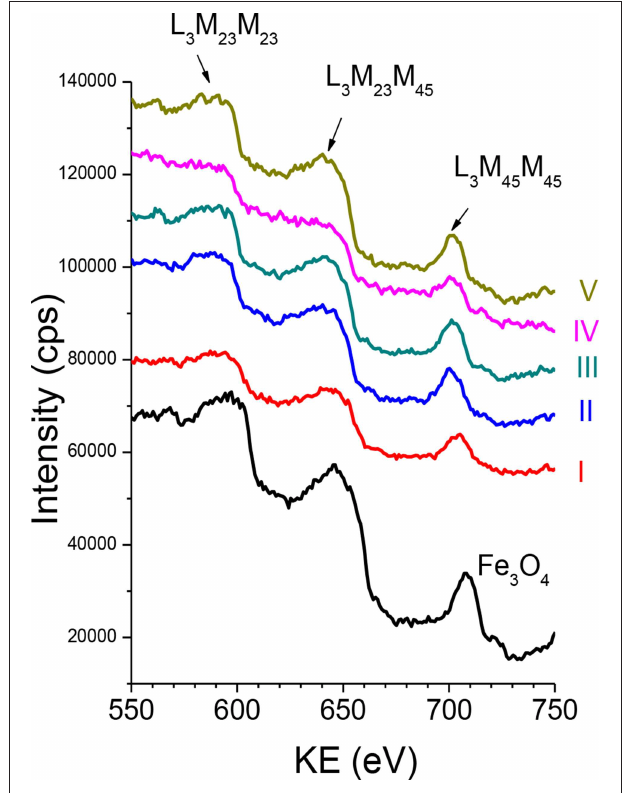
FIGURE 7 | The Fe L 3 VV Auger spectra recorded from Fe 3 O 4 MNPs and Fe 3 O 4 f-MNPs